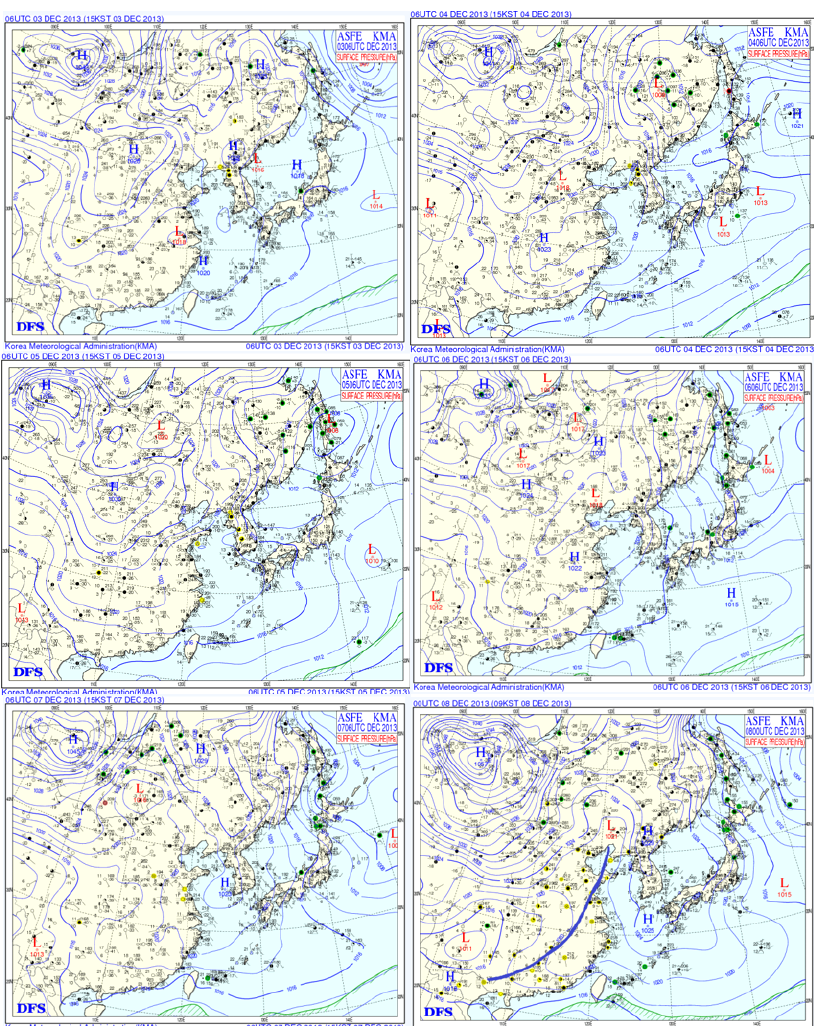
Figure 9. Surface weather maps from 3 to 8 December 2013. The black circles denote the measurement site (http://qixiangxinxifabupingtai.